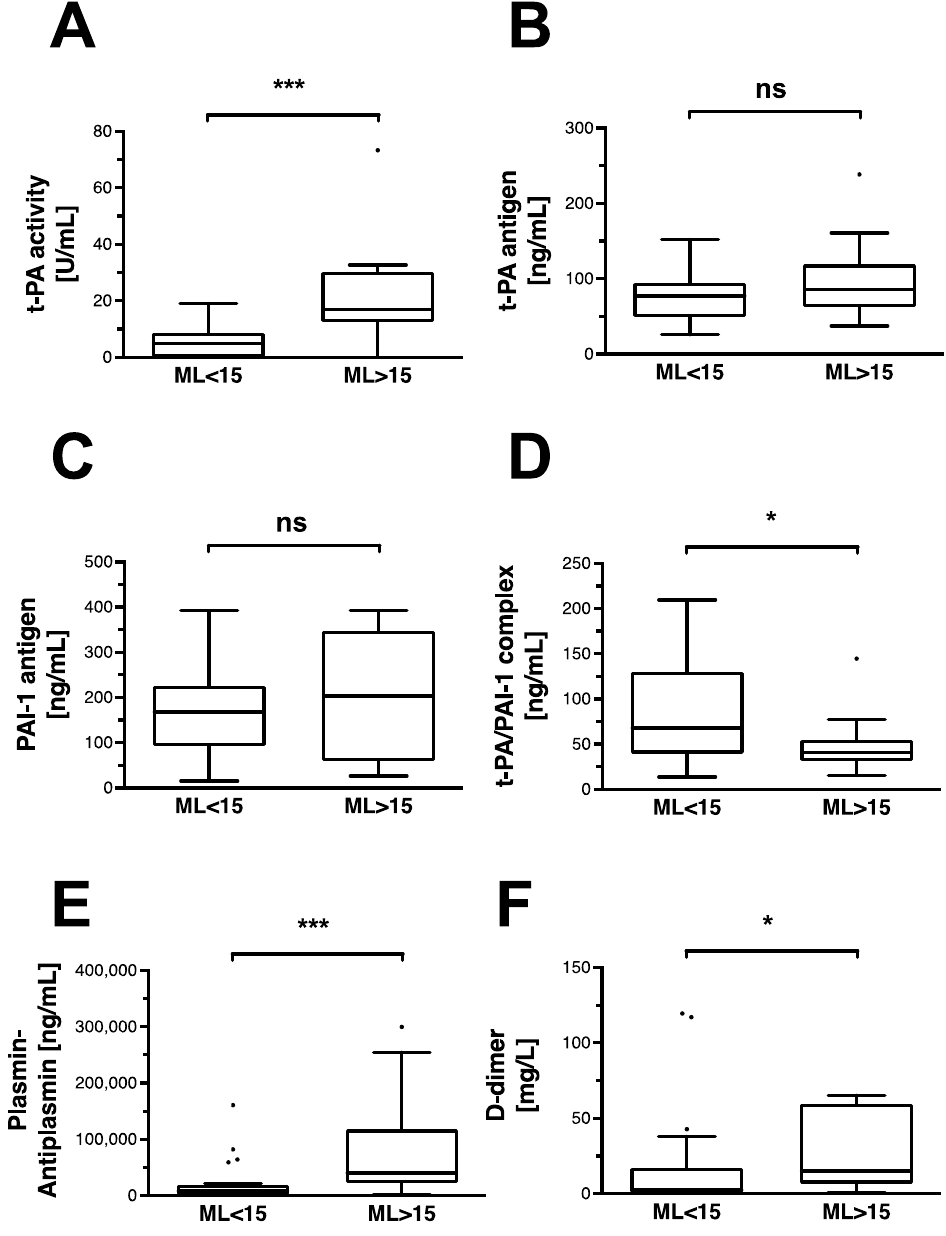
Figure 2. Classic fibrinolytic mediators and indicators of fibrinolysis in OHCA patients. Data are shown as box and whiskers blots with Tukey-style depiction of outliers. OHCA patients were stratified by ROTEM maximum lysis (ML). Hyperfibrinolysis was defined as a ML > 15%. Pa- rameters in patients with and without hyperfibrinolysis were compared with a Student’s t -test or Mann–Whitney test, where applicable. Differences in ( A ) t-PA activity and ( B ) t-PA antigen levels in OHCA patients with and without hyperfibrinolysis. Comparison of ( C ) PAI-1 antigen and ( D ) its complex with t-PA in OHCA patients with and without hyperfibrinolysis. Difference in circulating ( E ) plasmin–antiplasmin (PAP) and ( F ) D-dimer levels in OHCA patients with and without hyperfib- rinolysis. T-PA: tissue plasminogen activator; PAI-1: plasminogen activator inhibitor-1 * = p < 0.05; *** p < 0.001; ns =